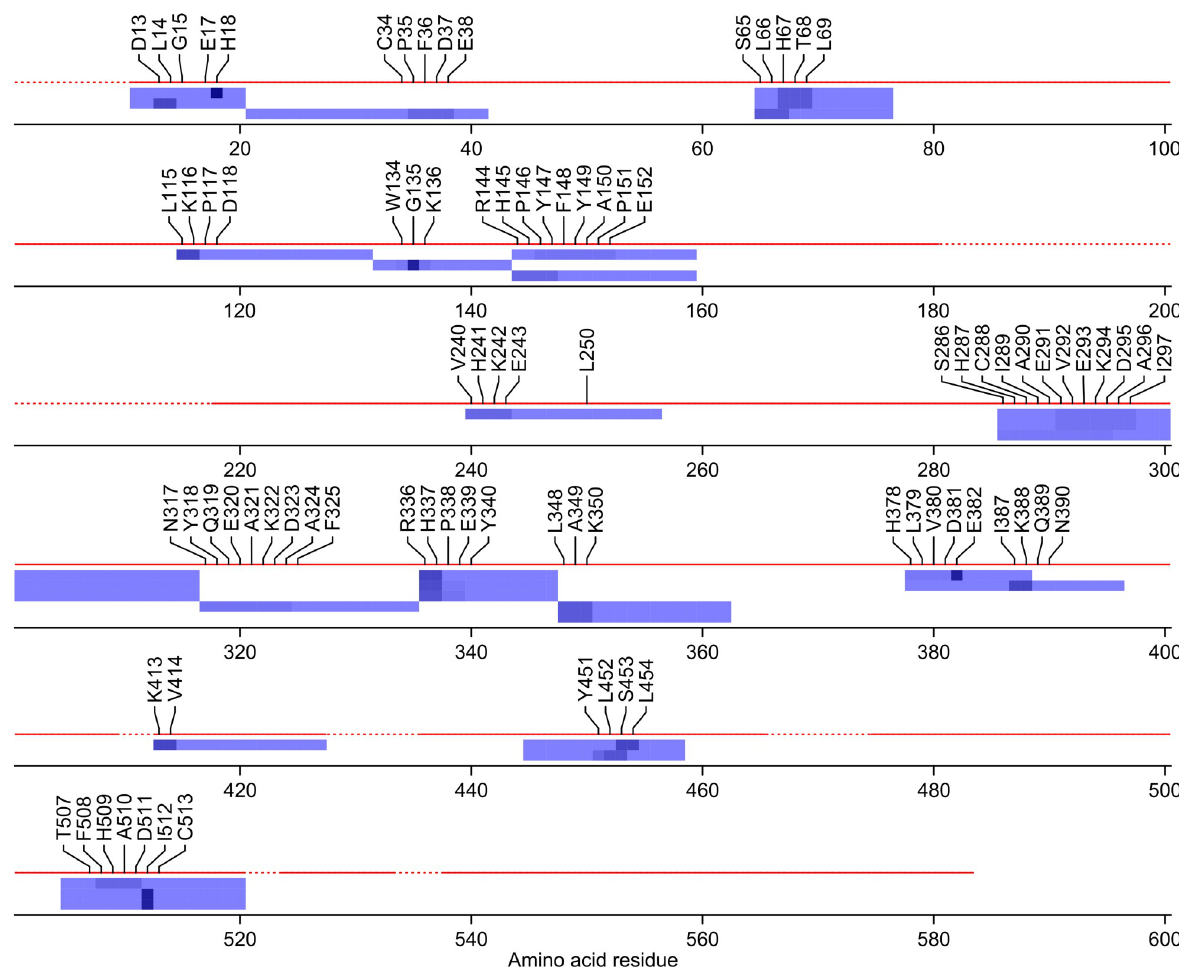
Fig 2. Localisation plot for putative hydrolysed N -ethylsuccinimidyl groups in N -ethylmaleimide-treated bovine serum albumin ( Δ m ± tolerance = +143.06 ± 0.01 Da). The protein sequence is represented as a dashed line that becomes solid in regions for which peptides were observed. X-axis values refer to positions in the protein sequence (position 1 = N-terminal amino acid residue). Dependent peptides are represented as coloured strips with shading to indicate the localisation probability (darker = more probable). Any site with a non-zero probability is annotated. One dependent peptide (amino acid residues 336–347, probably modified at Arg-336 or His-337) does not appear because the relevant matrices were full.